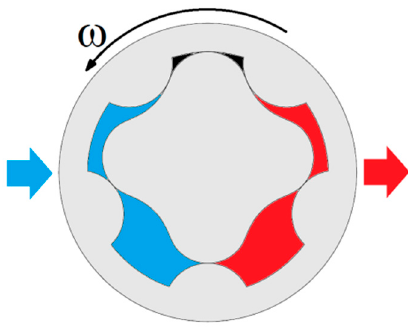
Figure 1. Gerotor pump scheme.